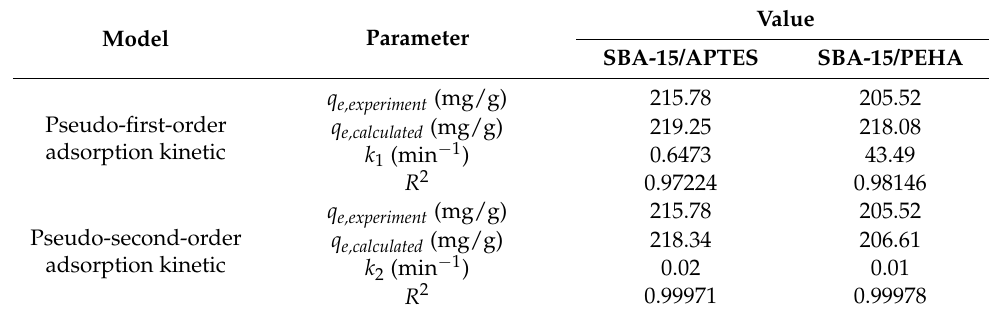
Table 5. Maximum adsorption capacity for TA adsorption onto various adsorbents.